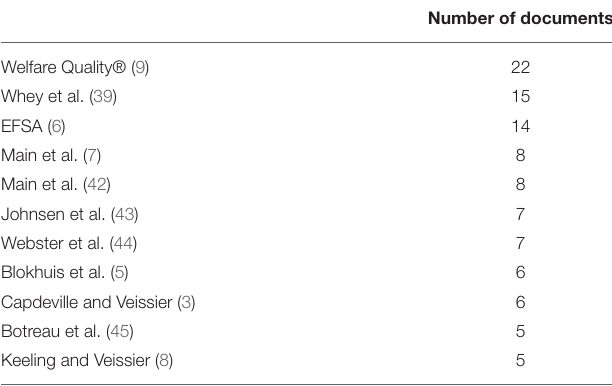
TABLE 5 | List of most cited papers (more than five times) as reference for the definition of the general codified animal-based measures term and number of documents in which they are cited in the corpus of the 199 retained